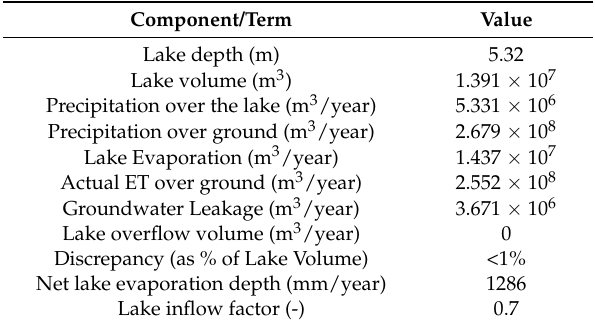
Table 3. Model estimated components of Lake Babati water balance